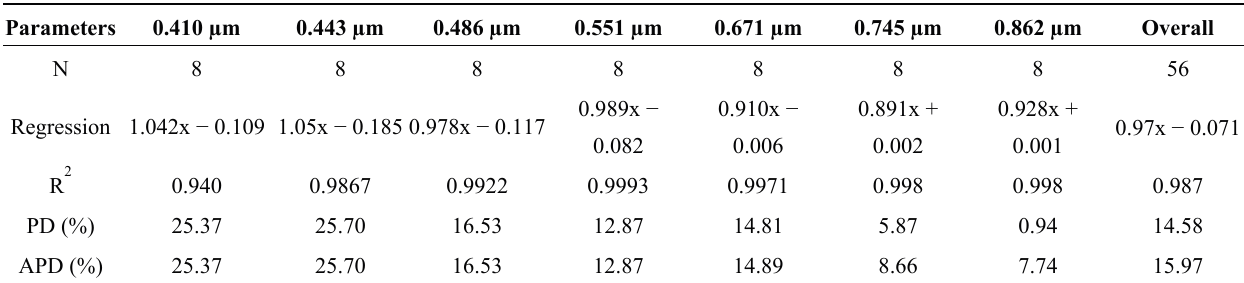
Figure 5. Scatter plots of VIIRS versus MODIS APS derived nLw estimates for the eight locations marked in Figure 1 and with each of the seven ocean color channels plotted separately. Table 2. Statistical results on the comparisons of nLw between MODIS and VIIRS for data collected over Chesapeake Bay areas on 10 January